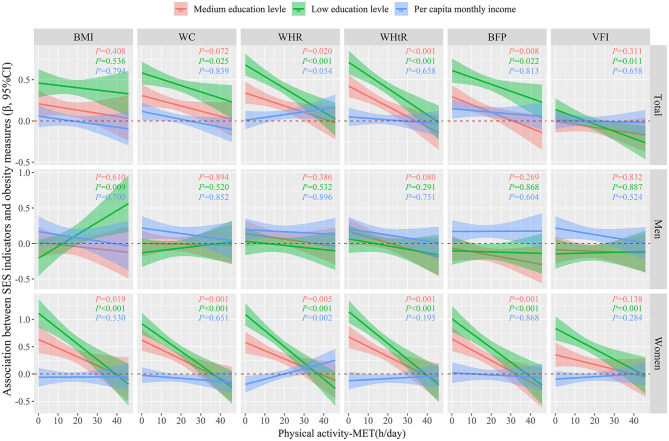
Regression associations between SES indicators and obesity measures (dichotomous) as a function of PA were evaluated by using generalized linear models, after adjusting for age, marital status, smoking status, drinking status, fruit and vegetable intake, high fat diet, education level or per capita monthly income. The lines and areas represented the estimated regression coefficient and 95% confidence intervals, respectively. SES, socioeconomic status; PA, physical activity; BMI, body mass index; WC, waist circumference; WHR, waist-to-hip ratio; WHtR, waist-to-height ratio; BFP, body fat percentage; VFI, visceral fat index.